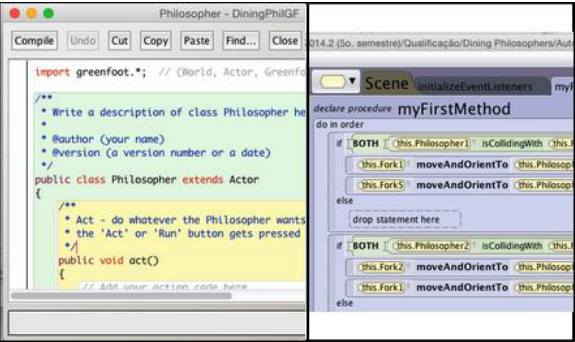
Fig. 7. Greenfoot code on Philosopher on the left, and Alice's code about the Philosopher, on Scene, on the right.